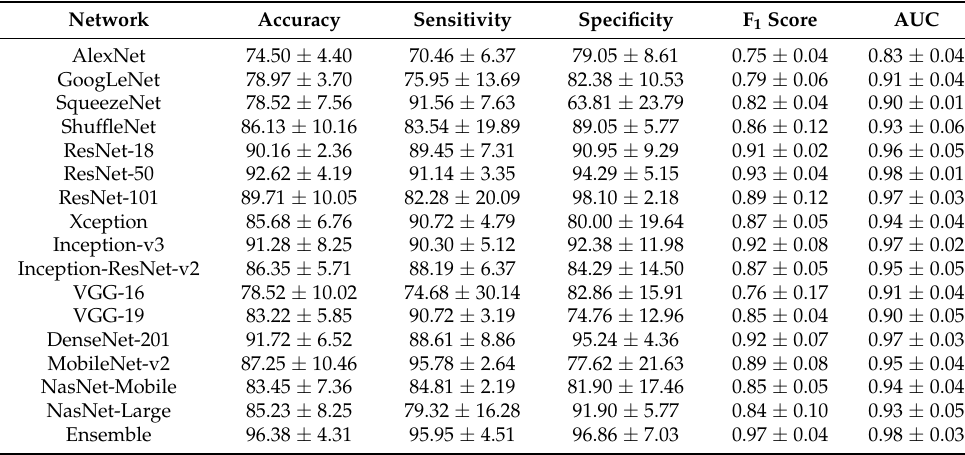
Table 3. Classification results with data